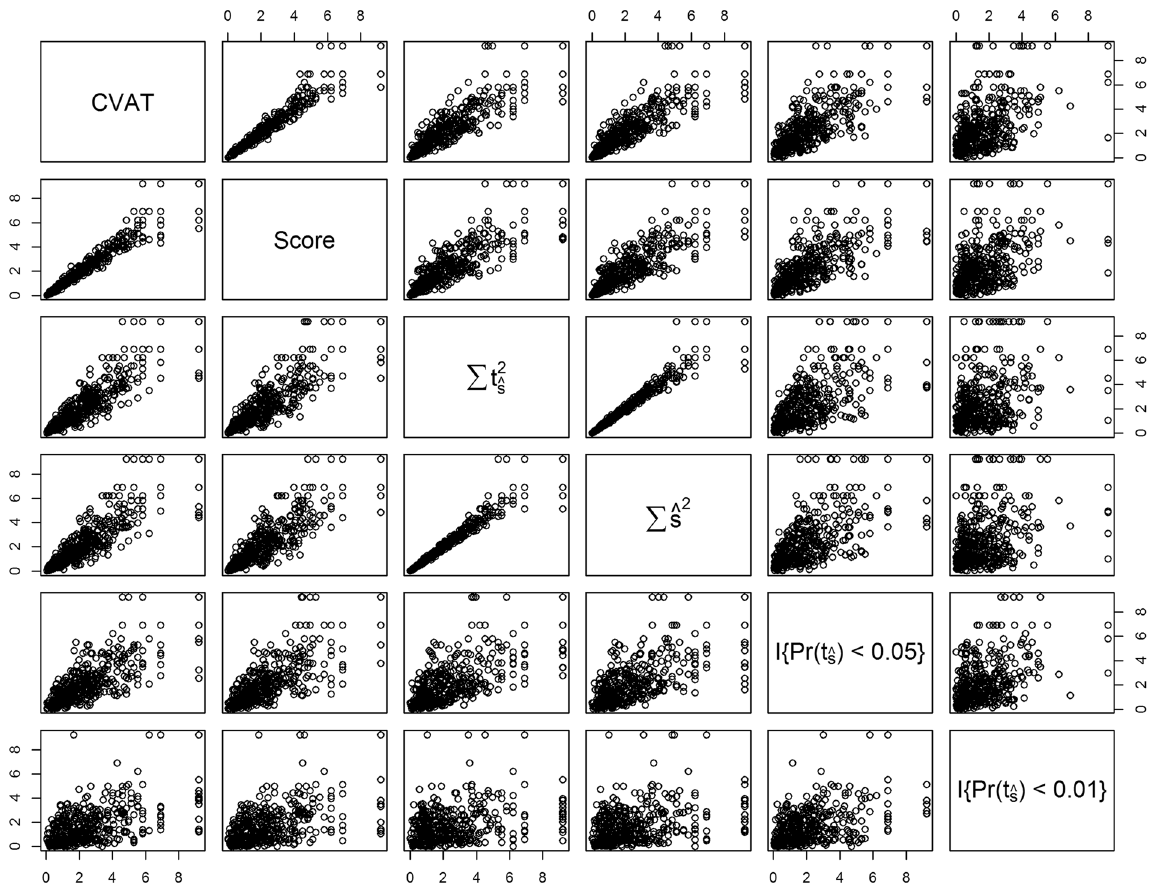
Figure 2. Relationship between the significance levels of different set test statistics. Scatter plots of all pairwise combinations of significance between the set test statistics, i.e. T CVAT (CVAT), T Score (Score), T Sum using single marker effects ∑ ^ ( s ) 2 or using single marker t-statistics ∑ ^ ( t ) s2 , and T Count with a threshold p-value < 0.05 < . and p-value < 0.01 < . . Significance, shown as − log(p), was measured for the ˆ (I{Pr(t ) 0 05}) s ˆ (I{Pr(t ) 0 01}) s association of simulated phenotype with genomic feature over a dilution range of adding 0 to 2000 non-causal SNPs to the C 1 causal set. Plots are arranged such that all plots in a row share a common y-axis, and all plots in a column share a common x-axis. The names of the x- and y-axes are shown in the diagonal boxes. Genomic heritability was set to 30% (h 2 = 0.3), and the proportion of genomic variance explained by the feature was 30% ( h f2 = 0.3). The random causal model was used, randomly selecting causal SNPs ( C 1 and C 2 ) from the complete set of SNPs. Five replicates were used within each line (N rep =